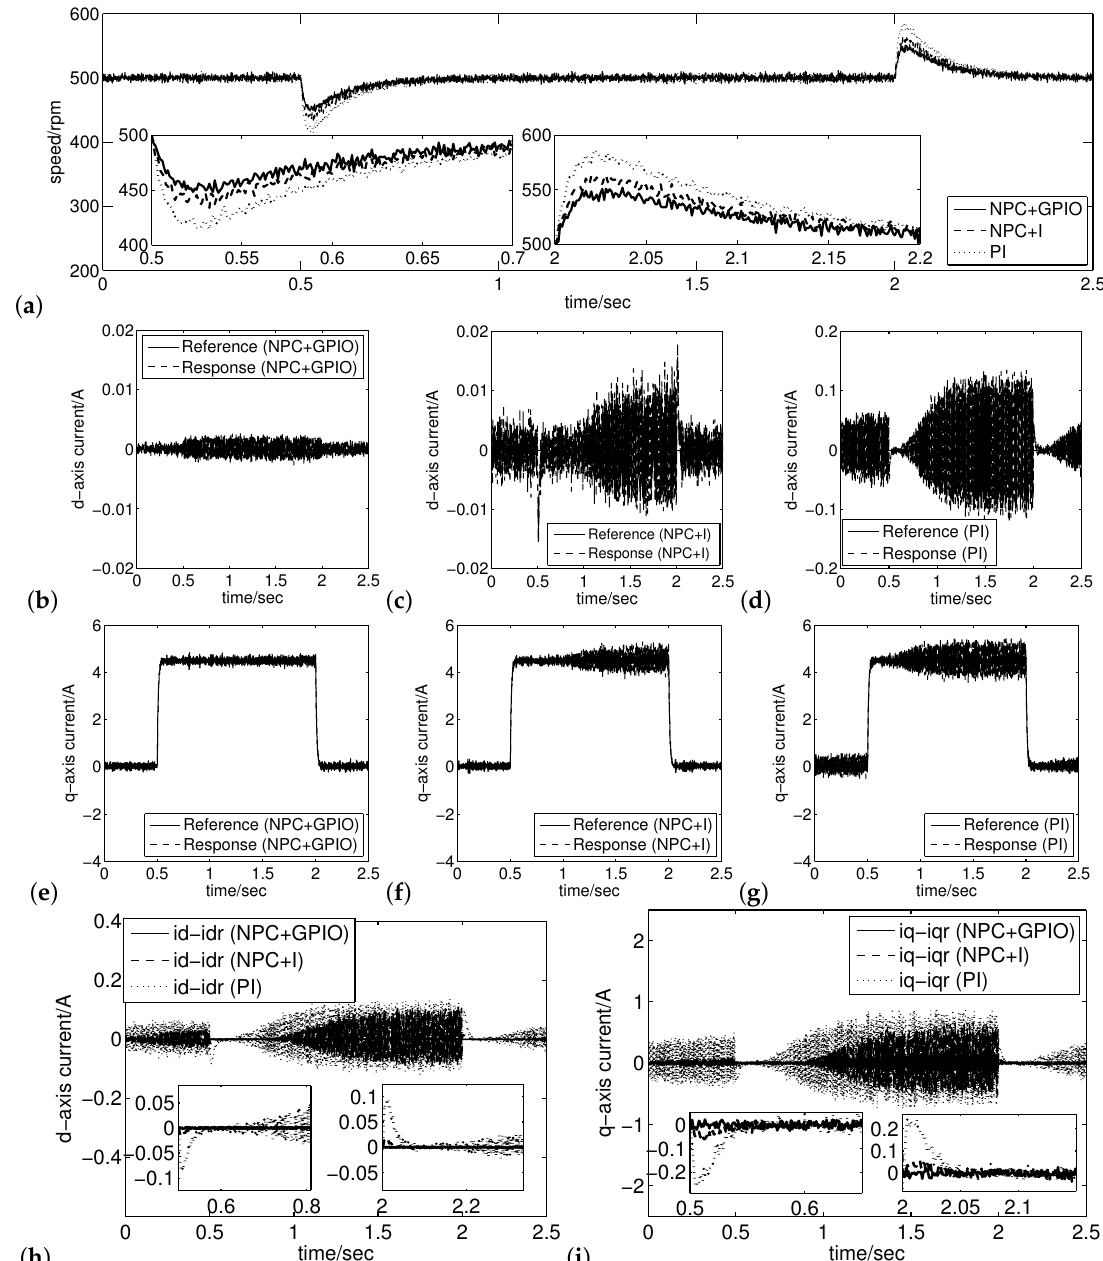
Figure 11. Speed and current responses with operation speed at 500 rpm in the case of 2.4 N · m load torque (nominal torque) under the same speed controller (PI) and the different current controllers (the proposed controller (NPC + GPIO), the integral controller (NPC + I) and the improved PI controller): ( a ) speed responses; ( b ) d-axis current response under the proposed controller; ( c ) d-axis current response under the integral controller; ( d ) d-axis current response under the PI controller; ( e ) q-axis current response under the proposed controller; ( f ) q-axis current response under the integral controller; ( g ) q-axis current response under the PI controller; ( h ) d-axis current-tracking errors under the different current controllers (the d-axis response current (id) minus the d-axis reference current (idr)); ( i ) q-axis current-tracking errors under the different current controllers (the q-axis response current (iq) minus the q-axis reference current